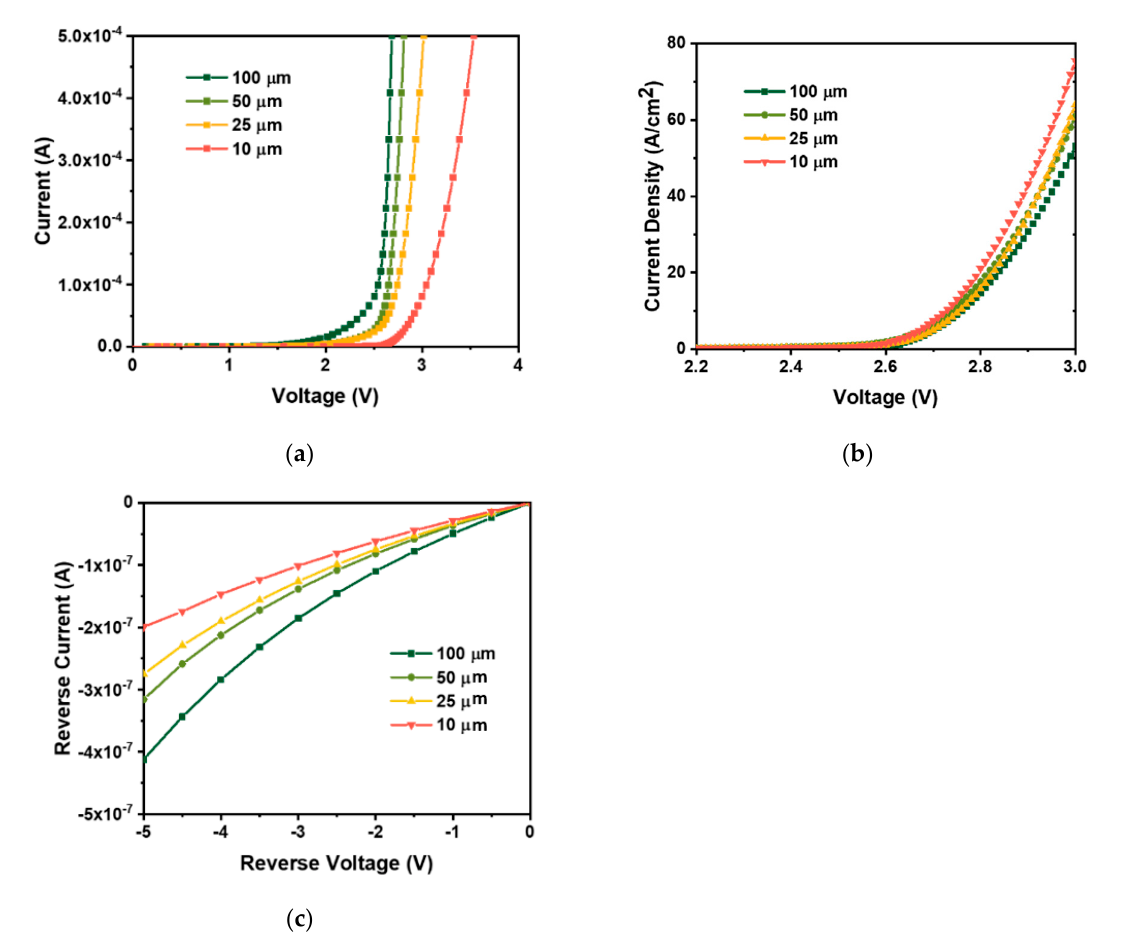
Figure 2. ( a ) Current–voltage (I-V) characteristics; ( b ) current density–voltage (J-V); and ( c ) reverse current–voltage characteristics for micro-LEDs the size of 100 × 100, 50 × 50, 25 × 25, and 10 × 10 μ m 2 .